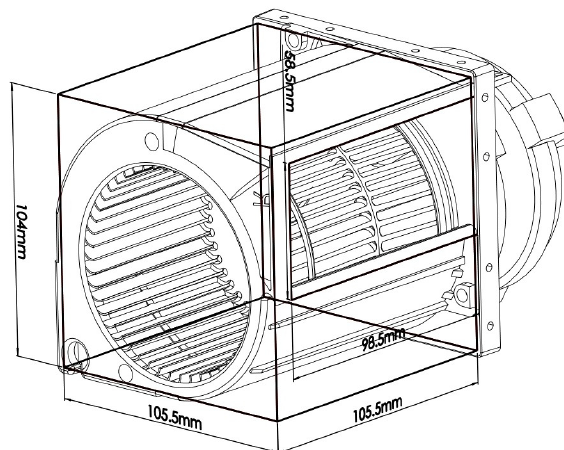
Figure 4. Internal configuration of the squirrel cage fan.